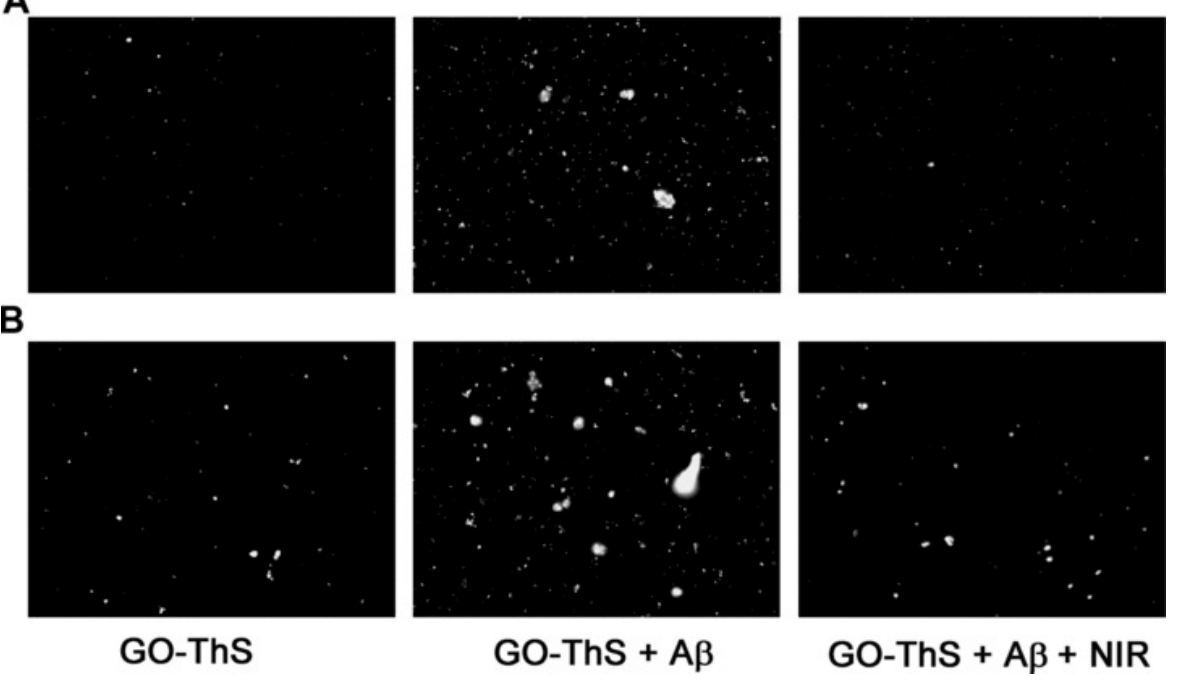
Figure 5. Fluorescence images of A β incubated with GO-ThS in Tris buffer ( A ) and mice CSF ( B ) (200x magnification) demonstrate that upon NIR irradiation GO-ThS can effectively dissociate A β amyloid deposits. Republished with permission from Ref. [15]. Copyright 2022 John Wiley and